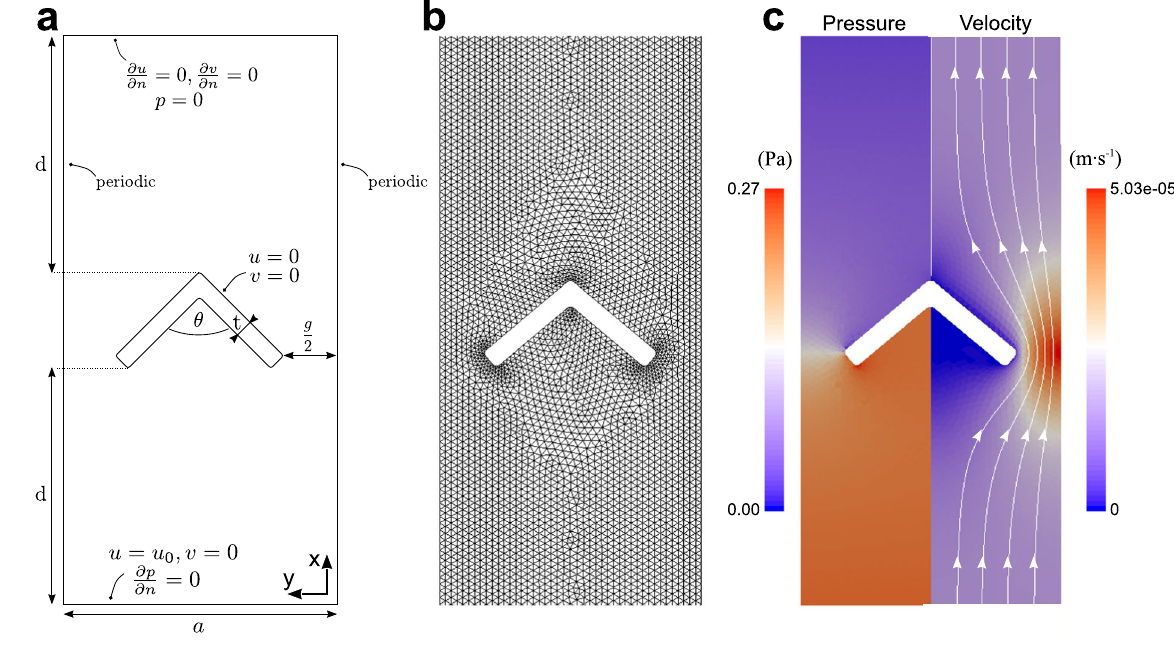
Figure 3. Computational analysis of the flow across hair bundles. ( a ) Geometry of the computational domain and boundary conditions. ( b ) Triangular discretization of the computational domain. ( c ) Exemplary computationally obtained solution for the velocity and pressure fields. Here the tip angle is θ = 100°, the gap parameter is γ = 0.33, and the height of the bundle is 4 μ m. The slice shown is at mid-height of the hair